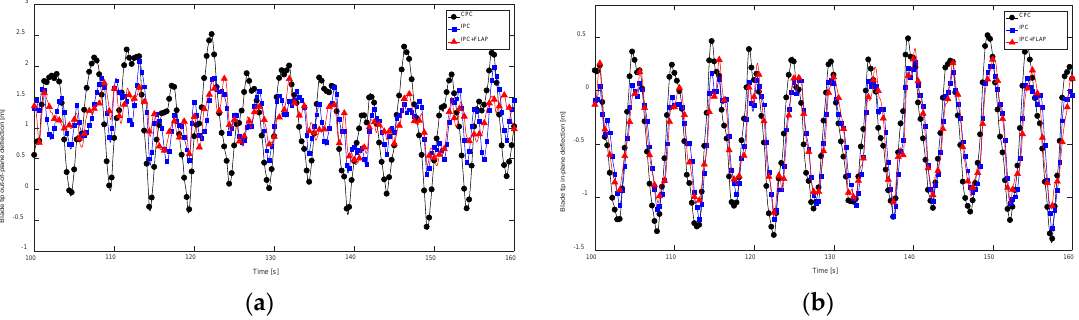
Figure 8. The blade tip deflections. ( a ) The blade tip out-of-plane deflections; ( b ) The blade tip in-plane deflections. Table 4. Standard deviation of blade tip deflections.